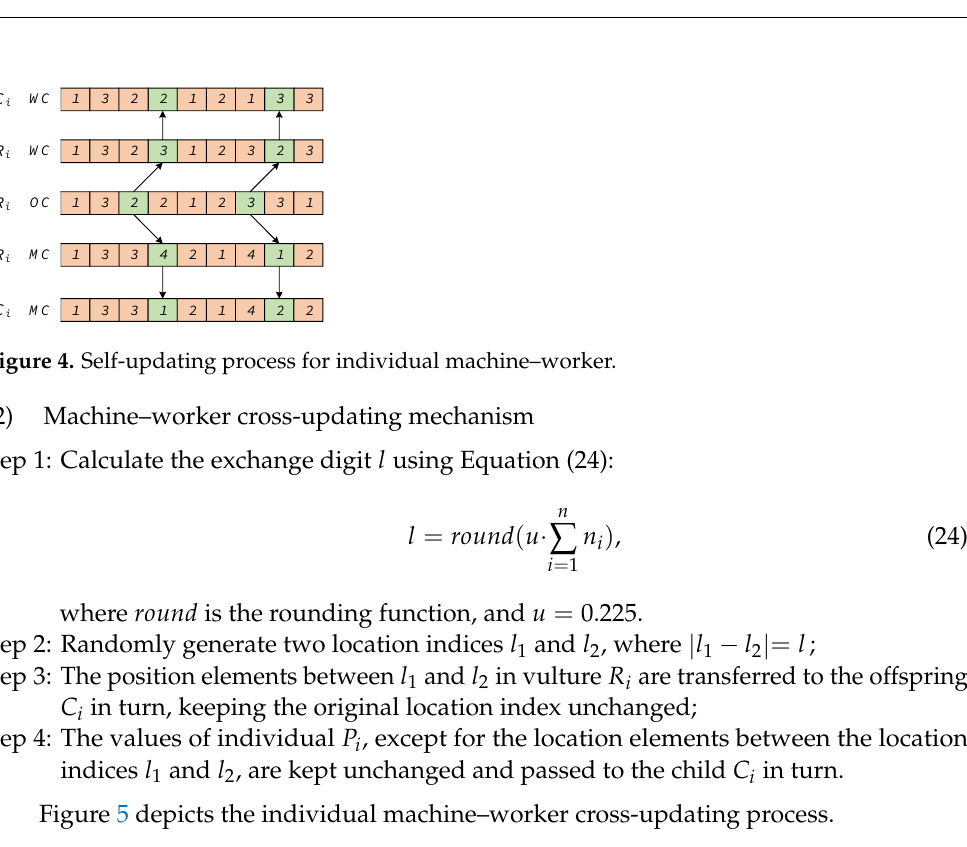
Figure 5 depicts the individual machine–worker cross-updating process.